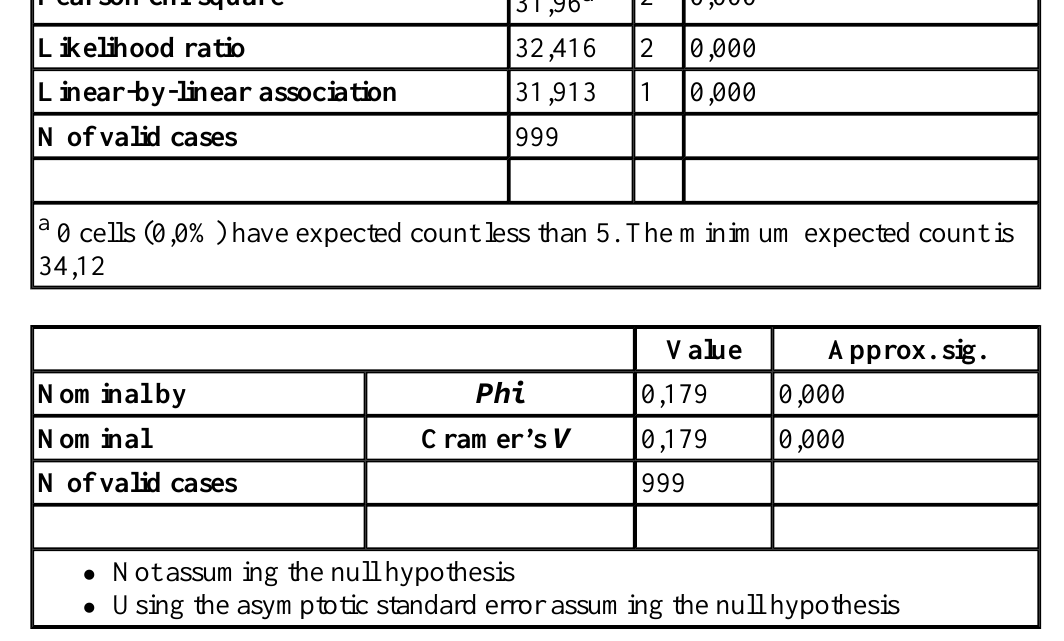
Figure 2 Results for Question 3: A ge of student (in full